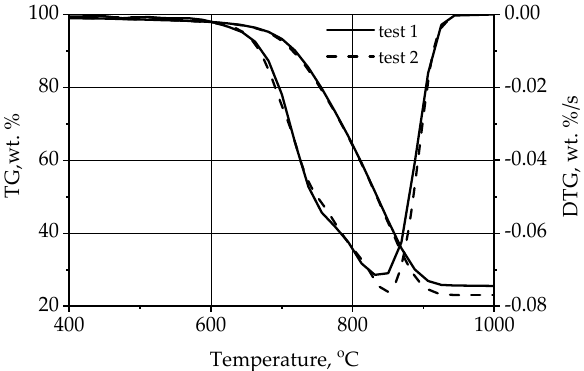
Figure 1. TGA and differential thermogravimetry (DTG) signals for the steam gasification of char derived from RPC. (heating rate 10 °C/min in 17 mol. % H 2 O concentration under argon).